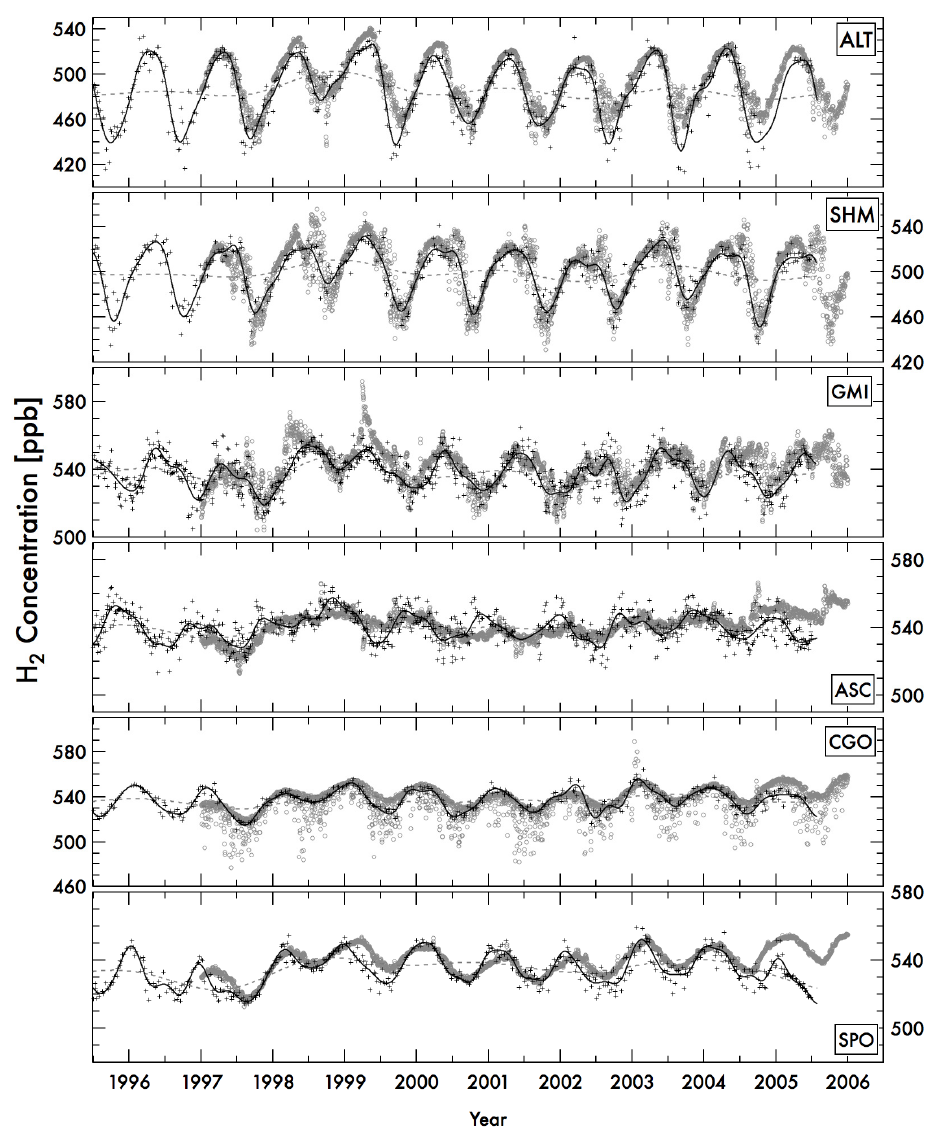
Fig. 3a. H 2 mixing ratios at selected observation sites; ALT(82.5 ◦ N), SHM(52.7 ◦ N), GMI(13.4 ◦ N), ASC(7.9 ◦ S), CGO(40.7 ◦ S), and Fig. 3a H mixing ratios at selected observation sites; ALT(82.5°N), 2 SPO(90.0 ◦ S). Abbreviations for each site are expressed in Table 1. Black circles are the observed values, dotted lines are the best fit curves to the data, dashed lines are the long-term trends, and gray circles are the values calculated using the CHASER model. SHM(52.7°N), GMI(13.4°N), ASC(7.9°S), CGO(40.7°S), and strong sources of H 2 , which cover the wide area around the SMO station, and the mixing ratio in the free troposphere